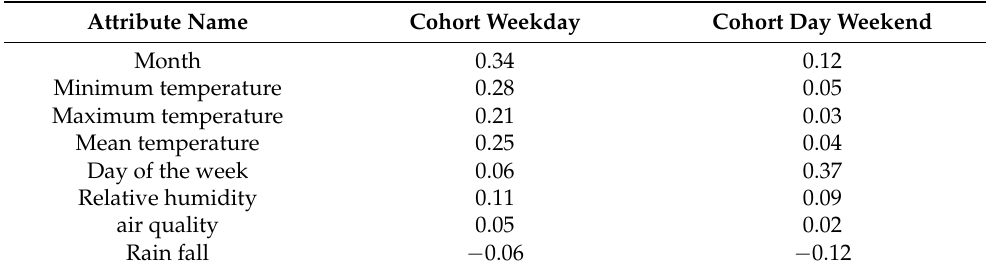
Table 3. Weight assigned to each